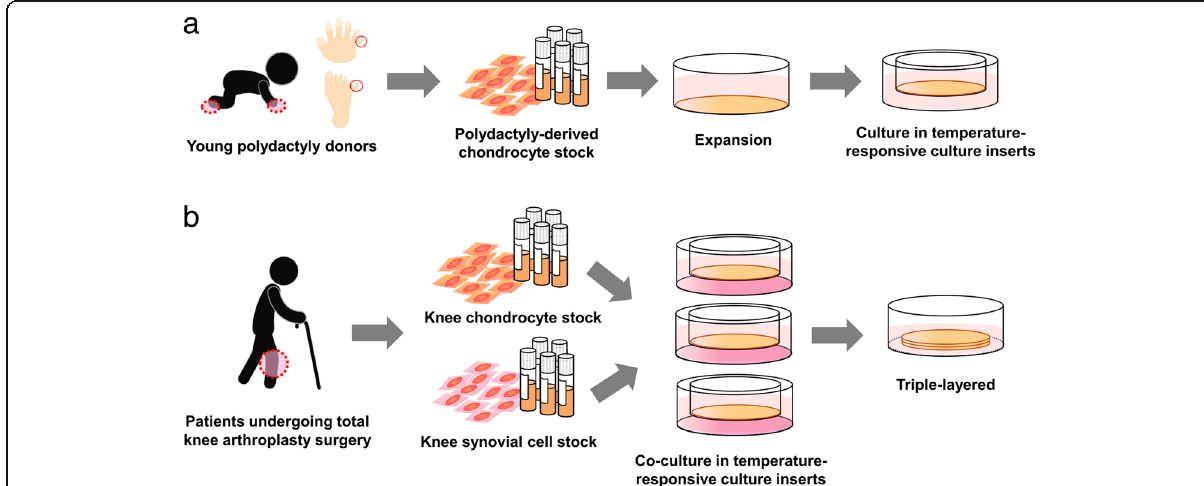
Fig. 1 Protocol for the fabrication of PD sheets and TKA sheets. a Fabrication of PD sheets. PDs obtained from polydactyly surgery were passaged once or twice and stocked at − 180 °C. After further expansion, P2 or P3 cells were seeded on temperature-responsive culture inserts and cultured for 2 weeks. b Fabrication of TKA sheets. Adult chondrocytes and synovial cells obtained from TKA surgery were stocked at P0 and P1, respectively. Chondrocytes were seeded on temperature-responsive culture inserts and cocultured with synovial cells for 2 weeks. Three chondrocyte sheets were layered and cultured for an additional